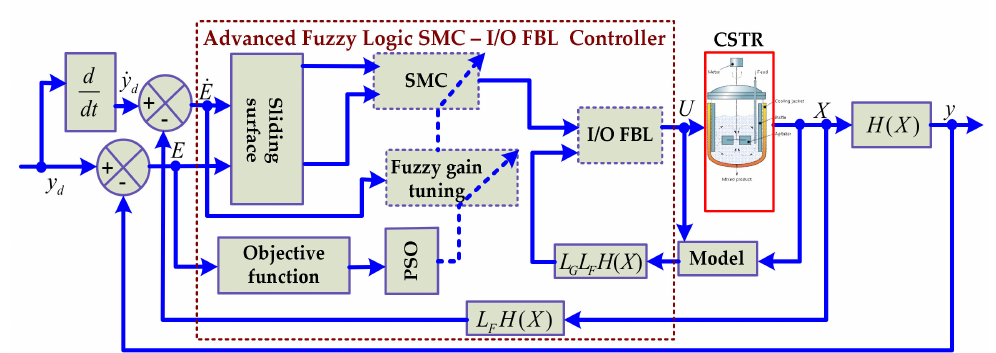
Figure 9. Block diagram of the advanced fuzzy logic SMC–I/O FBL controller.